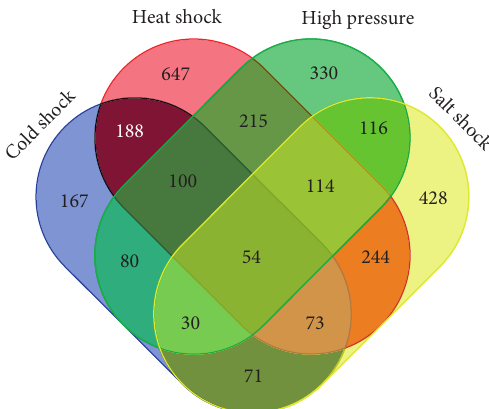
Figure 3: Venn diagram of the differentially expressed genes in- volved in the various environmental conditions. The figure is produced by using an online Venn diagrams tool (http://